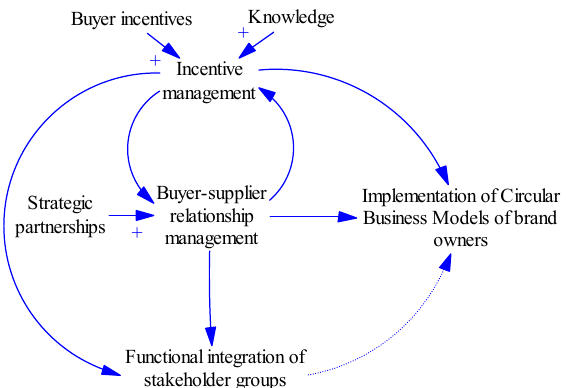
Figure 4. Causal loop diagram of the desired enablers and supplier tactics to break vicious cycles.